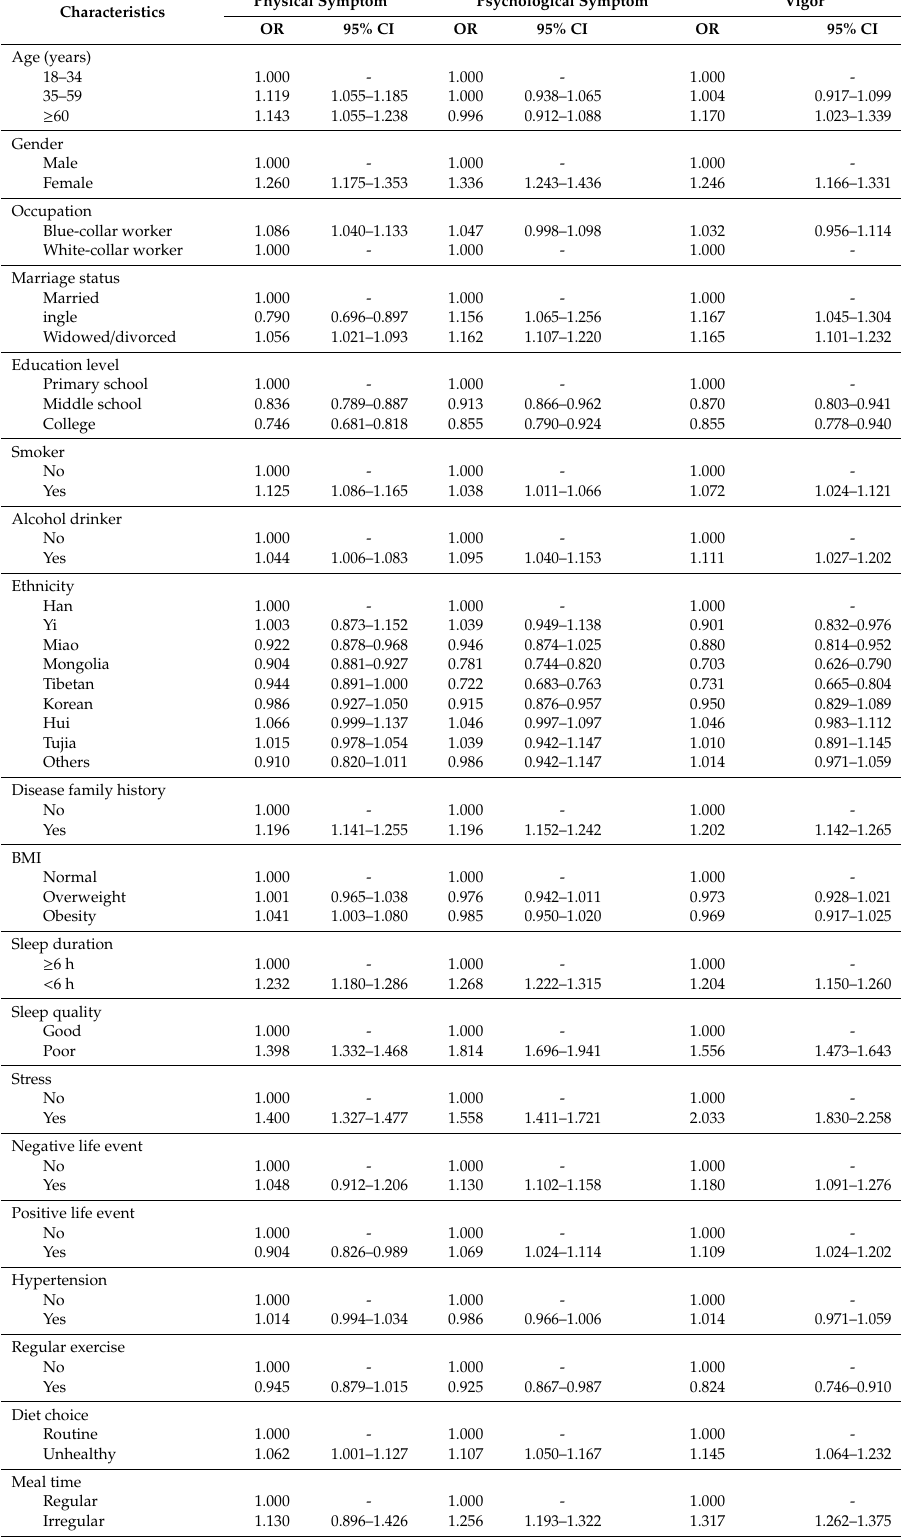
Table 4. Risk factors associated with each dimension of suboptimal health based on a multi-level multivariate GEE